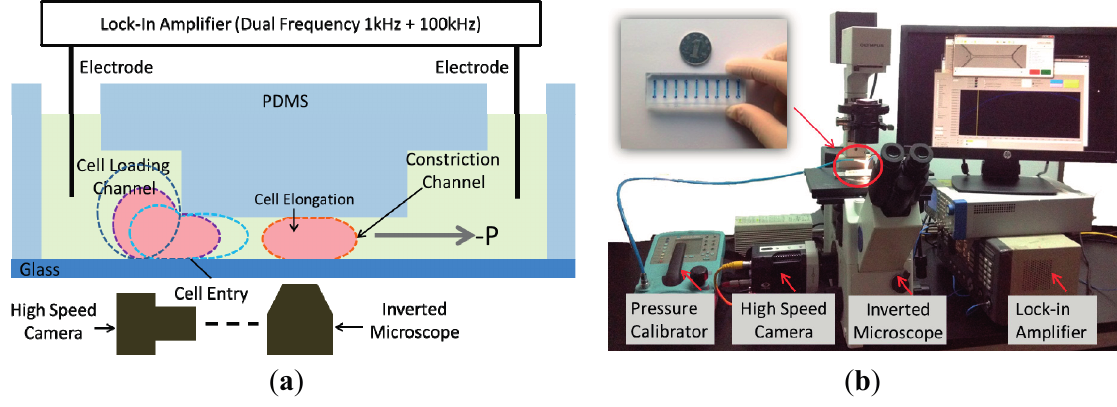
Figure 1. ( a ) Schematic and ( b ) setup of the microfluidic system for continuous characterization of E instantaneous and C specific membrane of single cells where cells are aspirated continuously through the constriction channel with cellular entry and traveling images as well as impedance profiles obtained simultaneously and translated to E instantaneous and C specific membrane based on proposed equivalent mechanical and electrical